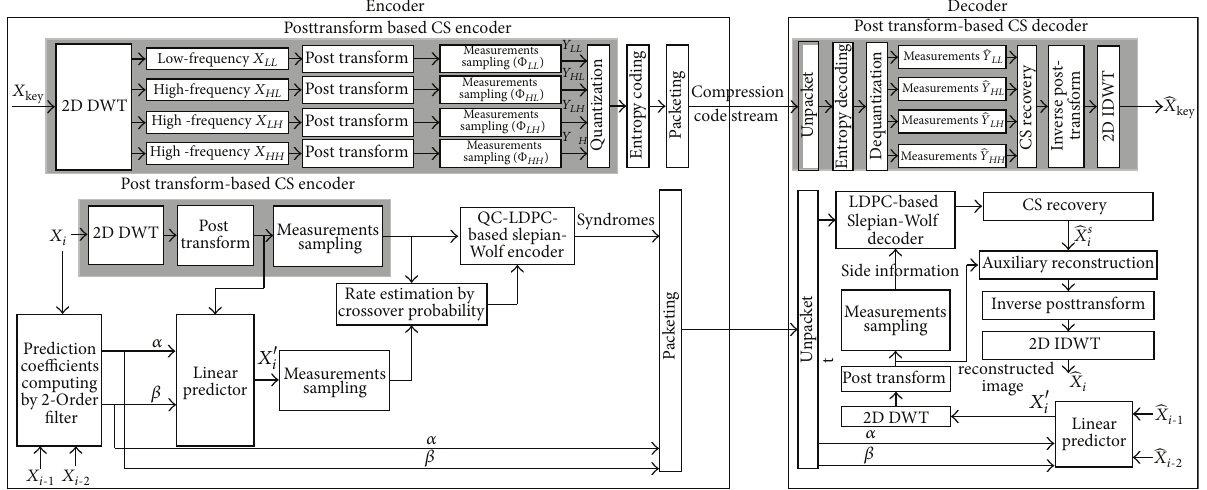
Figure 2: Proposed deep coupling coding architecture for multiband CCD images.